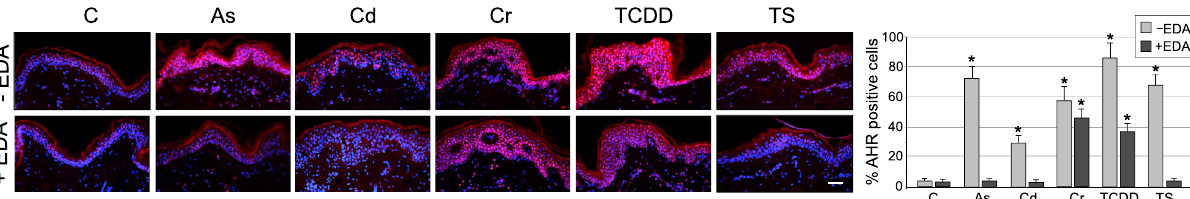
Figure 3. Deschampia antarctica aqueous extract (Edafence) revert the overexpression of the Aryl Hydrocarbon Receptor (AhR) induced by acute exposure of Human Skin Organ Cultures to common ambient pollutants. HSOC histological sections from control samples (C) or samples exposed to As(III), Cd(II), Cr(VI), 2,3,7,8-tetrachlorodibenzo-p-dioxin (TCDD) or Tobacco Smoke culture medium infusions (TS) pre-treated or not with Deschampia antarctica aqueous extracts (EDA) showing the fluorescent immunolocalization of the AhR protein. Images are representative of at least two different samples for each experimental condition. For quantifications, the ratio of positive cells for the indicated proteins in histological sections of HSOC samples was calculated as described in the Methods section. The mean + SD of the positive cell average (%) in two different samples for each experimental condition is represented (*, significant p ≤ 0.05). Bar: 100 strong increase in the cell death index is oberved in HSOC samples, and this increase is significantly prevented by pre-treatment with Deschampia antarctica aqueous leaf extracts (Fig. 2B). This fact suggest that the type and degree of tissue damage induced by an acute exposure of HSOCs to the toxic compounds used here, and in the concentration and time ranges described, is not in the scope of the molecular mechanisms able to trigger pro- grammed cell death signaling pattway. Next we have investigated changes in the intracellular expression/localization of the AhR in response to acute exposure of HSOCs to ambient pollutats. The AhR is a transcription factor activated by ligand binding that regu- lates the coordinated expression of different enzymes implicated in xenobiotics metabolism and is considered as a key molecular indicator of the response of mammalian cells and tissues to ambient pollutants exposure 30–32 .